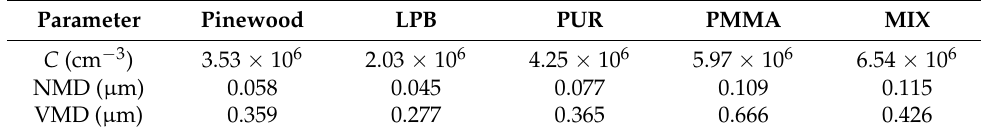
Table 1. The number concentration of particles ( C ), number median diameter (NMD), and volume median diameter (VMD) obtained using HT-ELPI for pinewood (PINE), laminated particle board (LPB), polyurethane (PUR), poly(methyl methacrylate) (PMMA), and the sample containing all materials